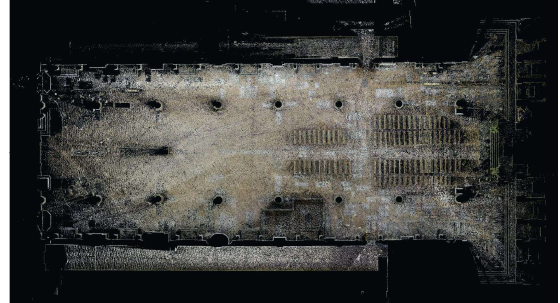
Figure 4 . Three-dimensional point cloud of the central nave of the Basilica of Santa Croce, Florence. Photogrammetry is a crucial step, and the only solution to obtain accurate metric information about the lost foundations. However, its implementation is technically challenging, since the available photographs are not optimised for photogrammetry: they overlap mildly, they have modest resolution, and lack colour. The dataset, in fact, consists of 12 black and white (1307x1303 pixel and 3.24 MB) and low resolution (even if acquired with high resolution scanner setting 600 dpi) images of the foundations (shown in Figure 2), with 40% of overlapping.